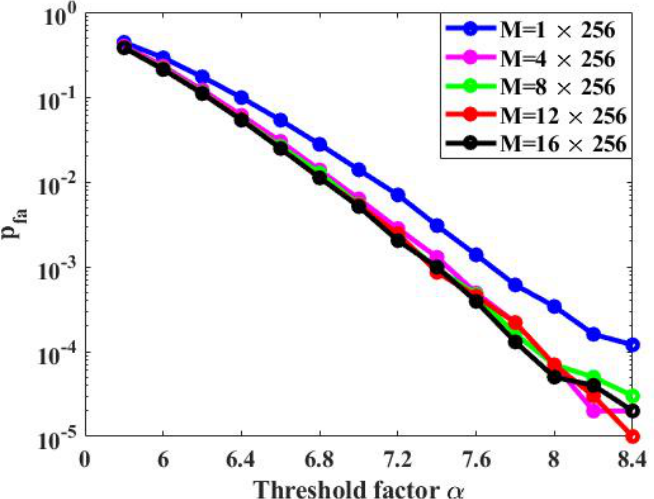
Figure 12. Relationship between threshold factor and false alarm rate in